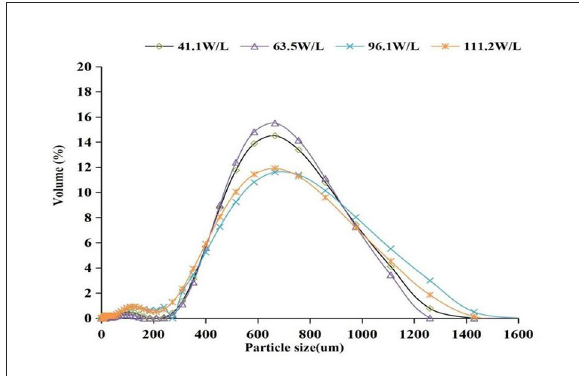
FIGURE6 Particle size distribution of grape pomace at different acoustic energy densities.